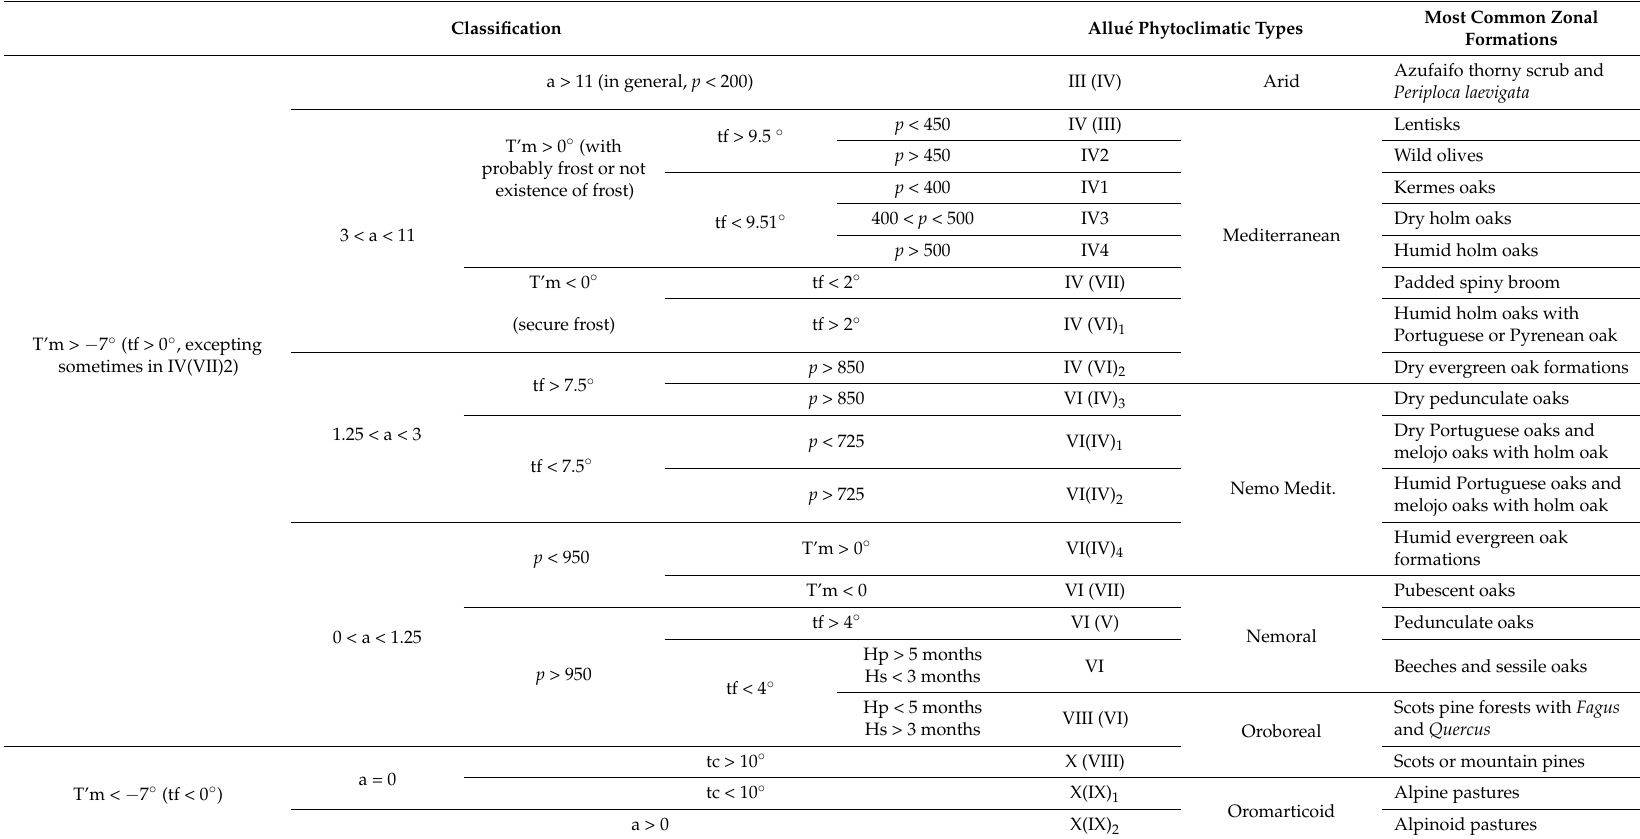
Table 2. Summary of the phytoclimatic Allu é (1990) regions used in this study. The spatial distribution of the phytoclimatic types is displayed in Figure 3.